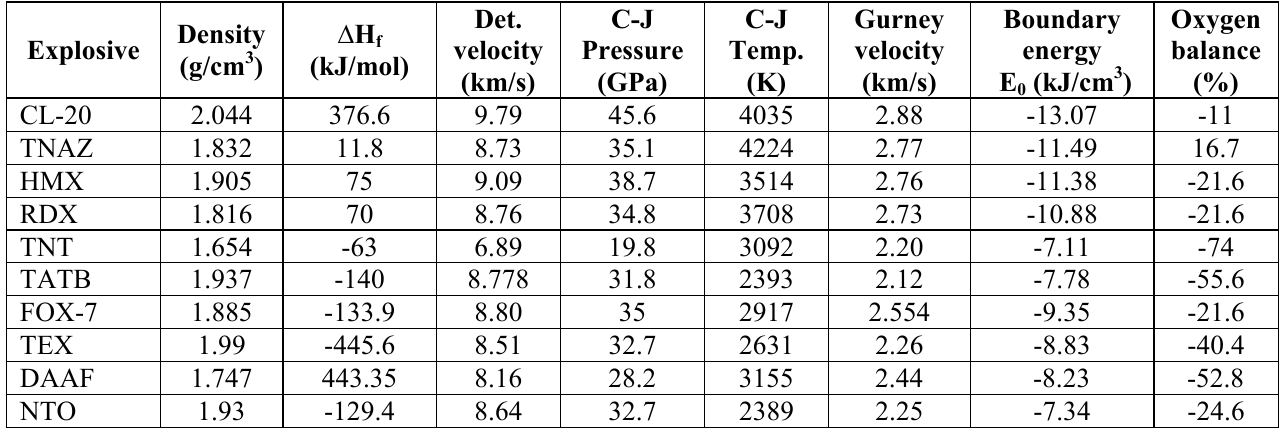
Table 4. Jaguar predicted detonation